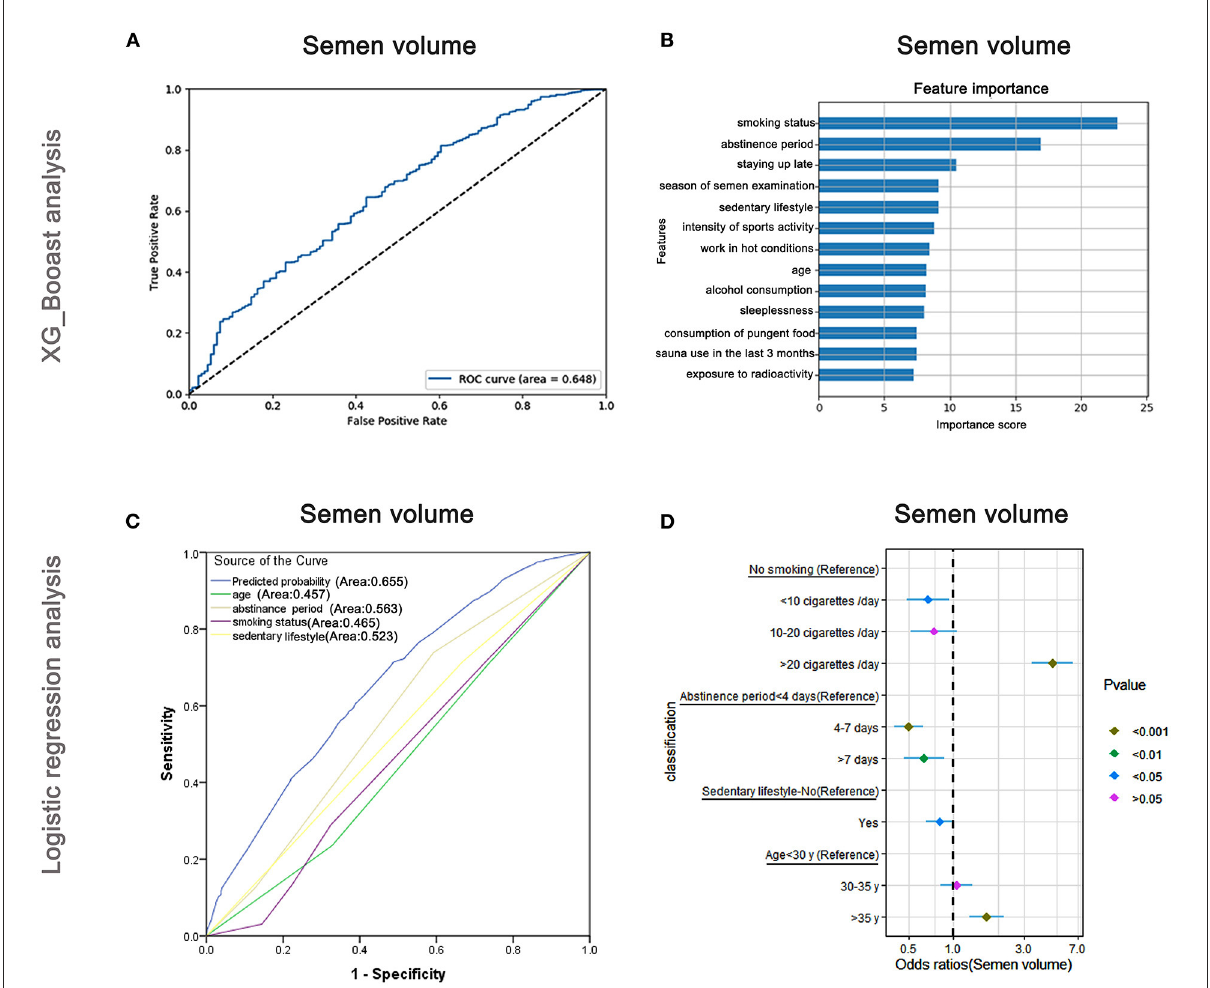
FIGURE3 XGBoost and logistic regression analysis of the risk factors for semen volume. The ROC curve (A) and feature importance (B) analyzed by XGBoost and the ROC curve (C) and forest diagram showing significant risk factors (D) analyzed by logistic